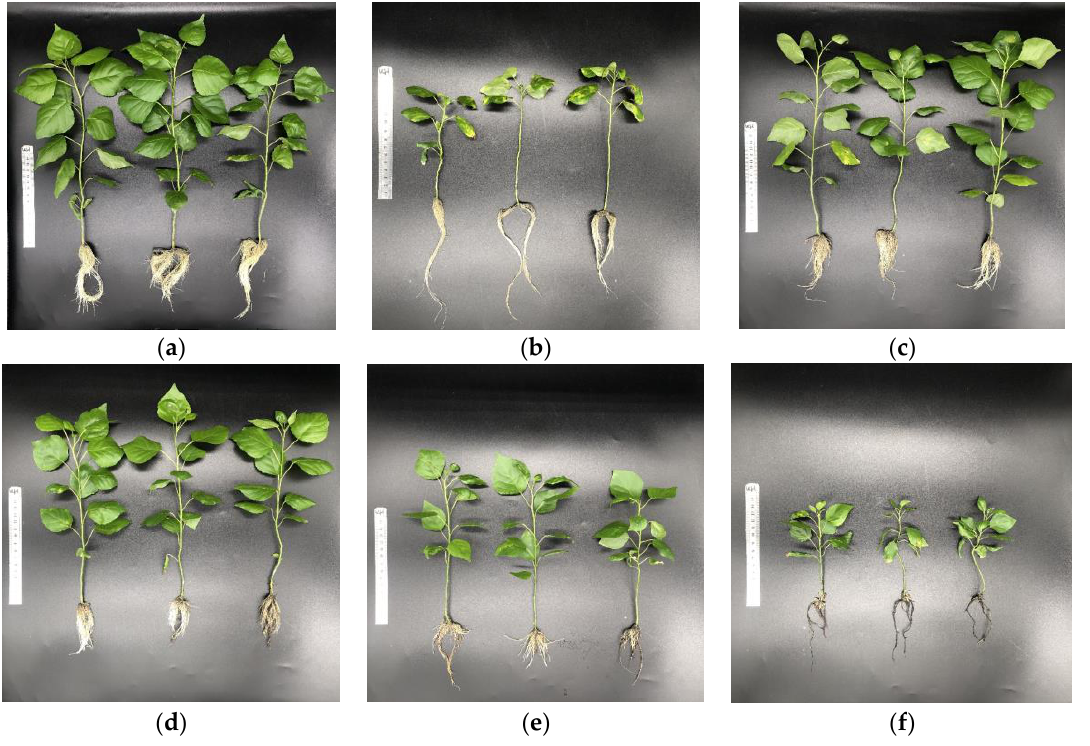
Figure 1. Phenotypical changes of exogenous asparagine (Asn) on poplar ‘Nanlin895’ growth. Plants were grown in ( a ) 3 mM KNO 3 (N+), ( b ) N-free hydroponic solutions (N0), ( c ) 0.1 mM Asn, ( d ) 0.5 mM Asn, ( e ) 2 mM Asn, and ( f ) 5 mM Asn for two months.